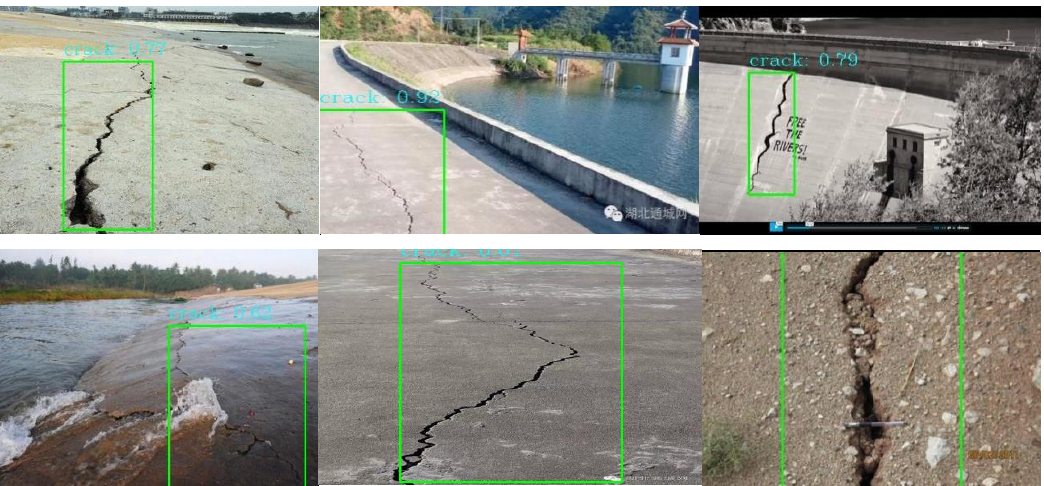
Figure 15. Dam crack detection results.